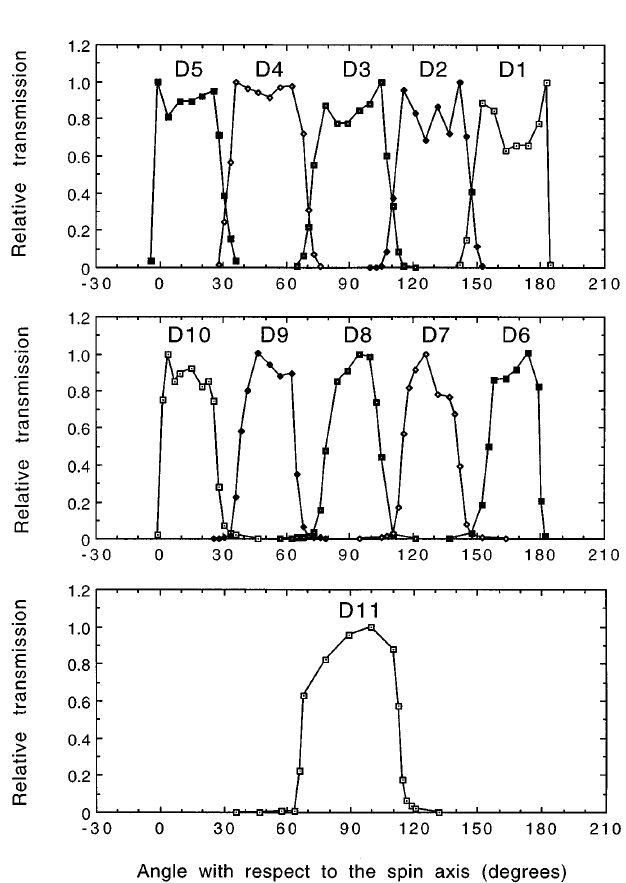
Fig. 5. Viewing directions for the di(cid:128)erent detectors of TRICS and the direction of the satellite spin axis